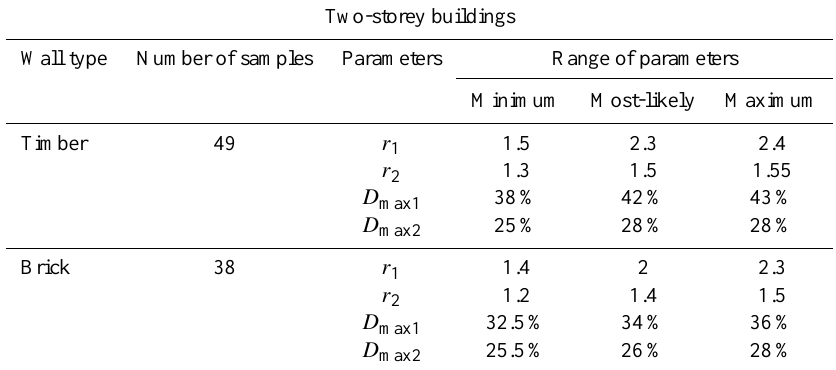
Table 3. Number of samples and range of r and D max values, calculated by the bootstrap and chi-square test for two-storey buildings.